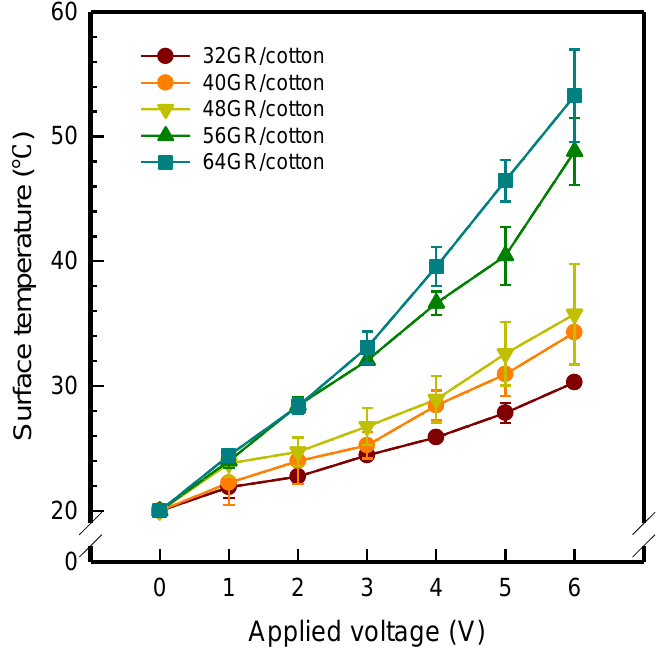
Figure 7. Variation of surface temperature of GR / cotton coated with various high-content of graphene nanoplatelets.